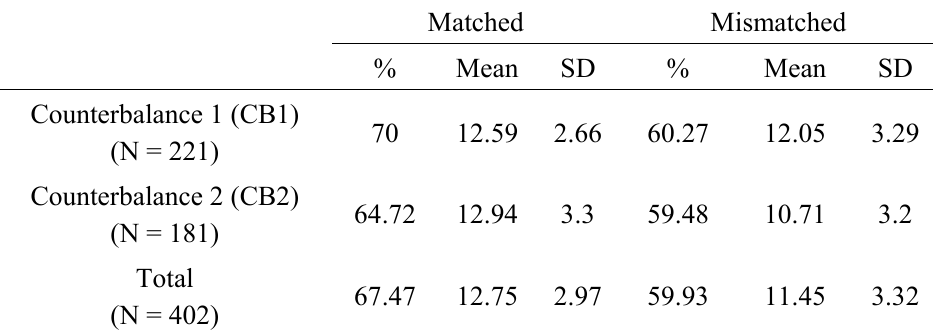
Table 1. Means, SD and percentage correct answers for both